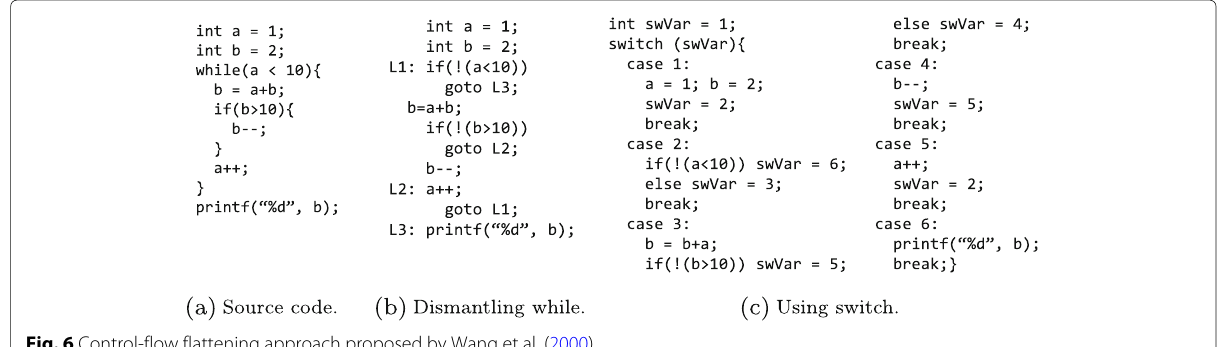
Fig. 6 Control-flow flattening approach proposed by Wang et al.